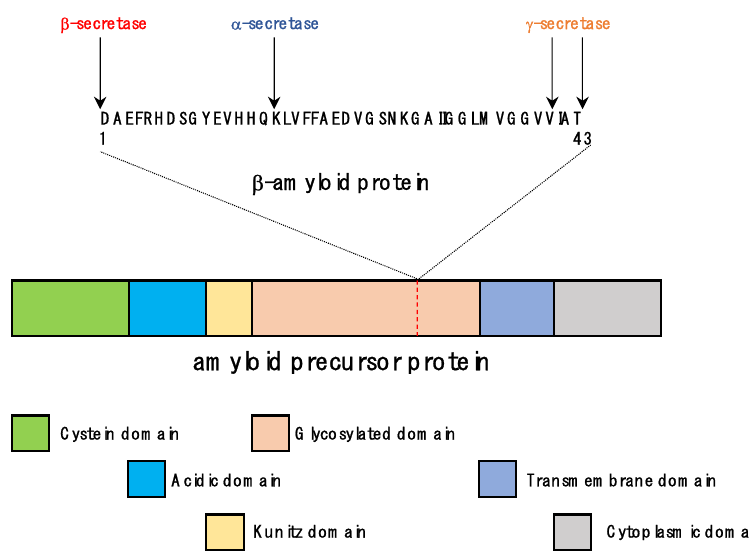
Figure 1. Domains and secretase sites of action of the APP (Amyloid precursor protein). APP is a transmembrane protein composed of 6 domains. From the N-terminal region these domains include a cystein domain, an acidic domain, kunitz-type protease inhibitor domain (not present in APP 695 ), a glcosylated domain and a cytoplasmic domain. The glycosylated domain contains the amyloid beta sequence cleaved by α-, β-, and γ-secretase.